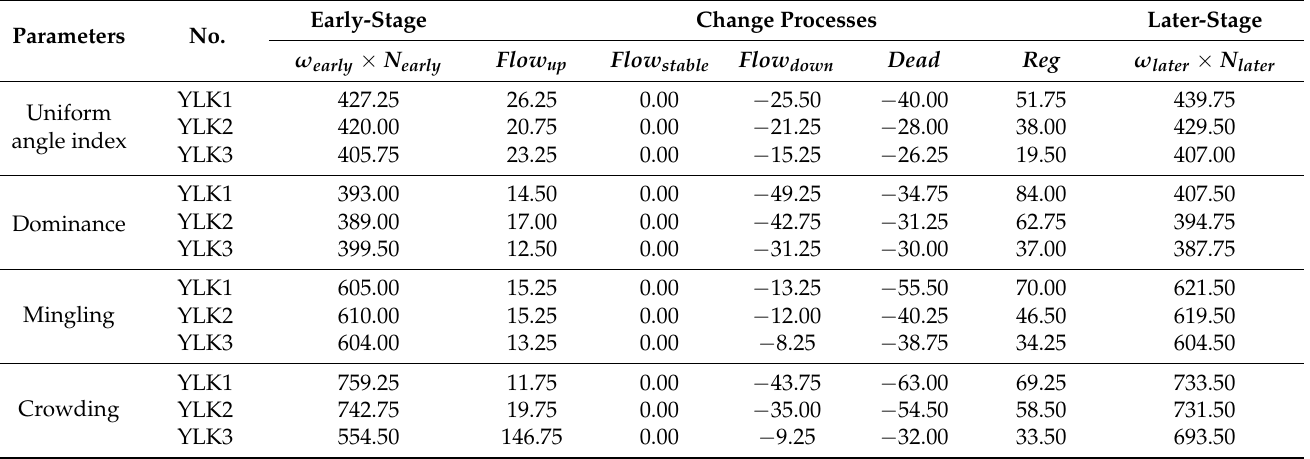
Table 5. Disentangle the changes in spatial structure. The values in the table equal to the sum of the product the type value and quantity of SSSPs (see equations in Section 2.4). Positive and negative values in the change processes indicate an increase and decrease in the total value of SSSPs from early-stage to later-stage,